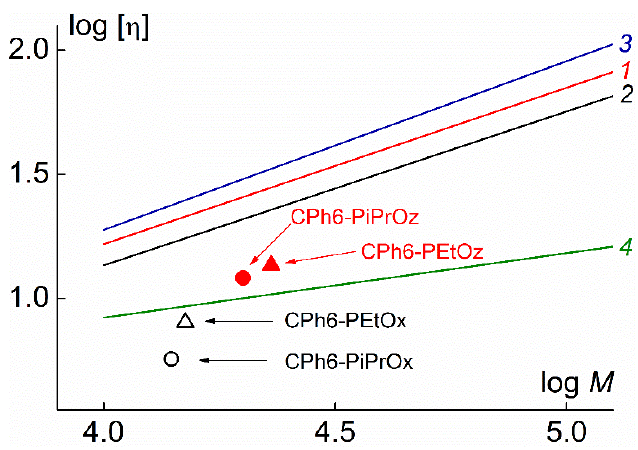
Figure 7. Intrinsic viscosity [ η ] vs. molar mass M for the studied polymer stars in chloroform and MKHS dependences for linear PEtOx ( 1 [26] and 2 [59]), PMeOx ( 3 [26]), and star-shaped eight-arm C8A-PS ( 4 [53]).